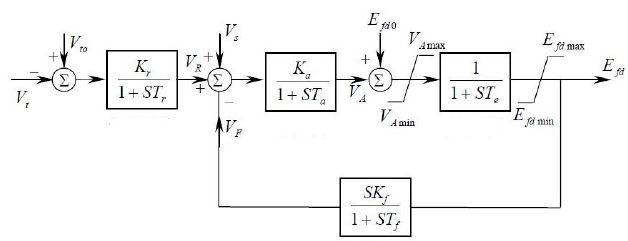
Figure 1. Exciter model.